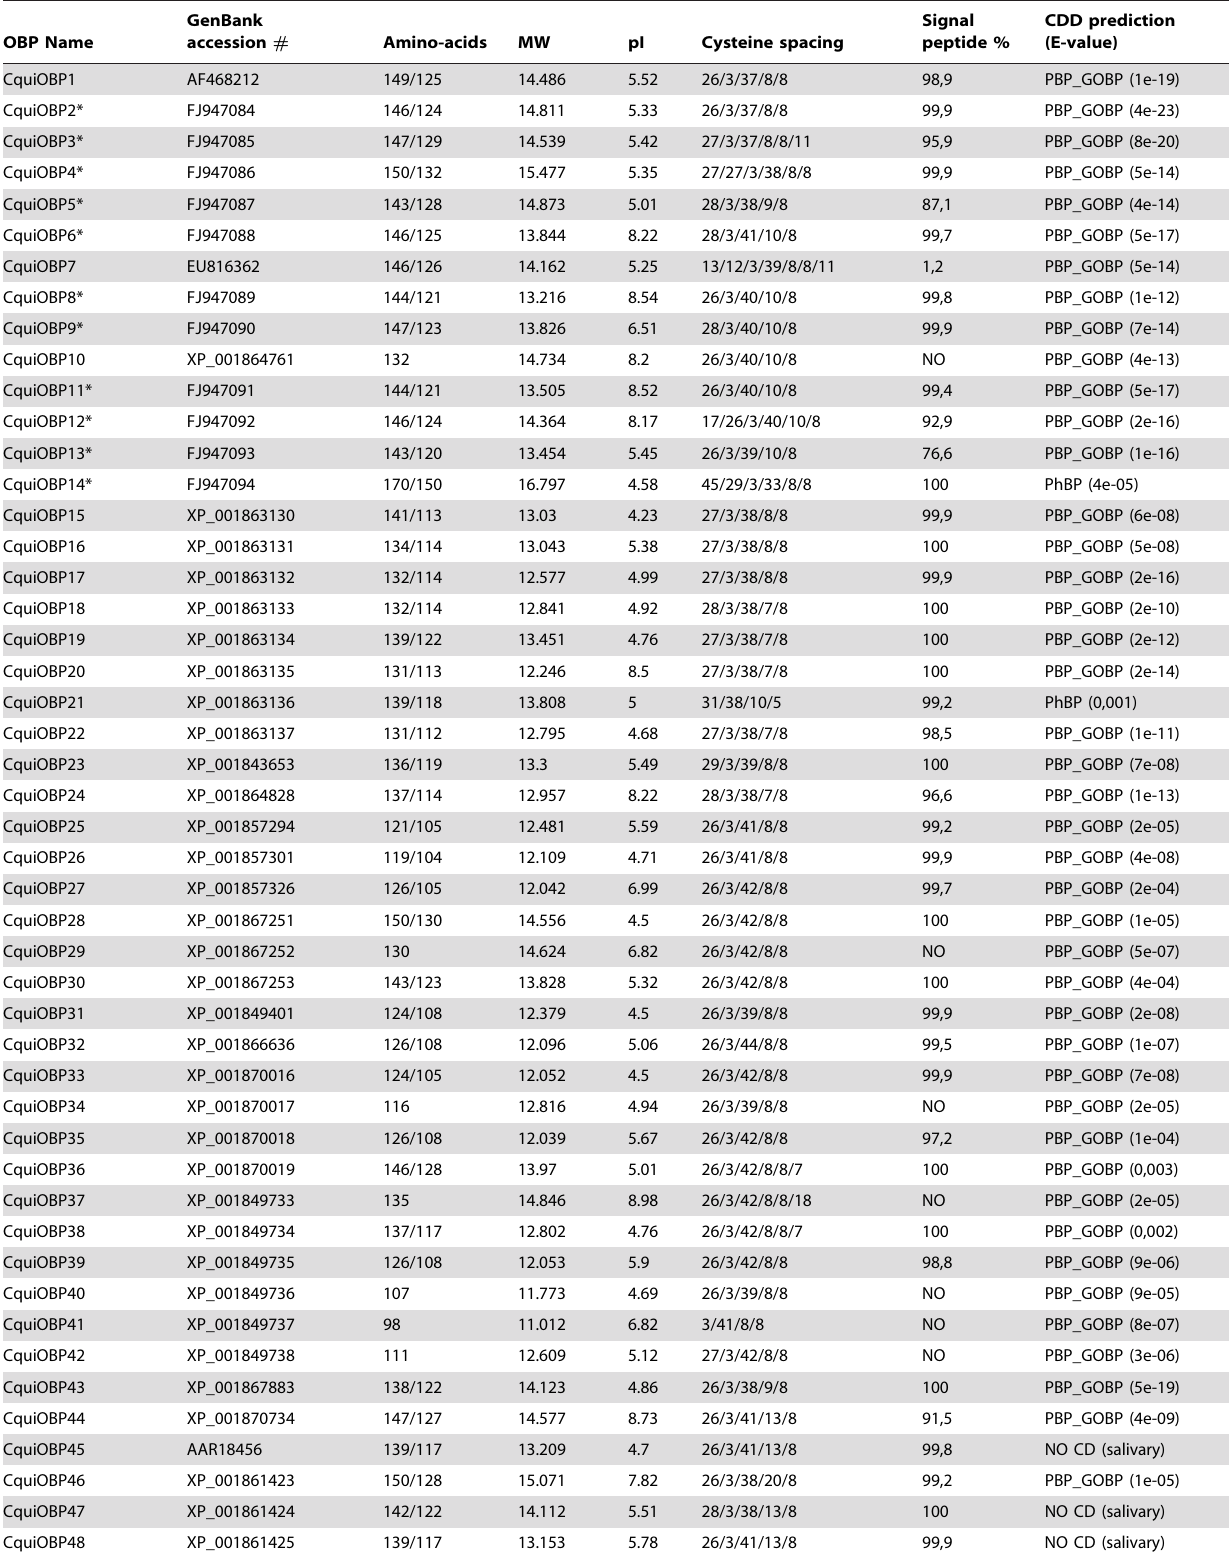
Table 1. Structural characteristics of Cx. quinquefasciatus putative